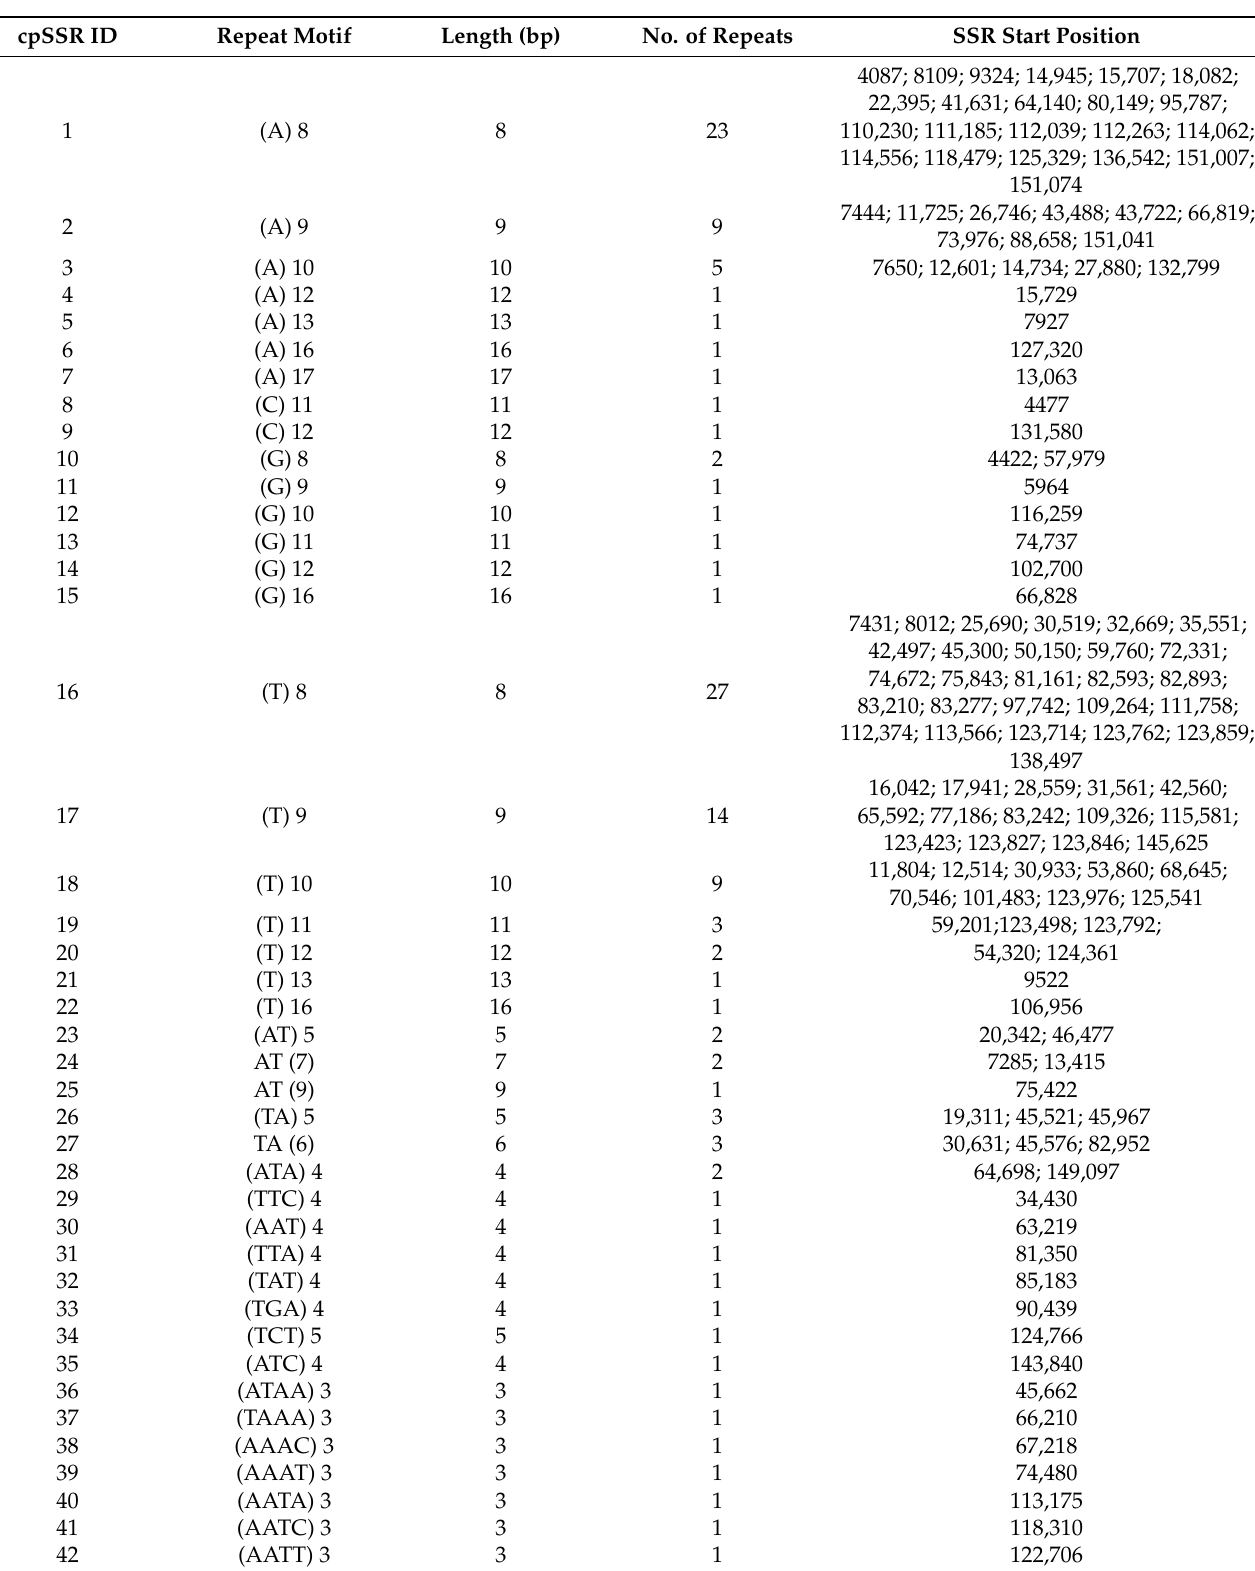
Table 5. Microsatellite in the chloroplast genome of H. forskaolii